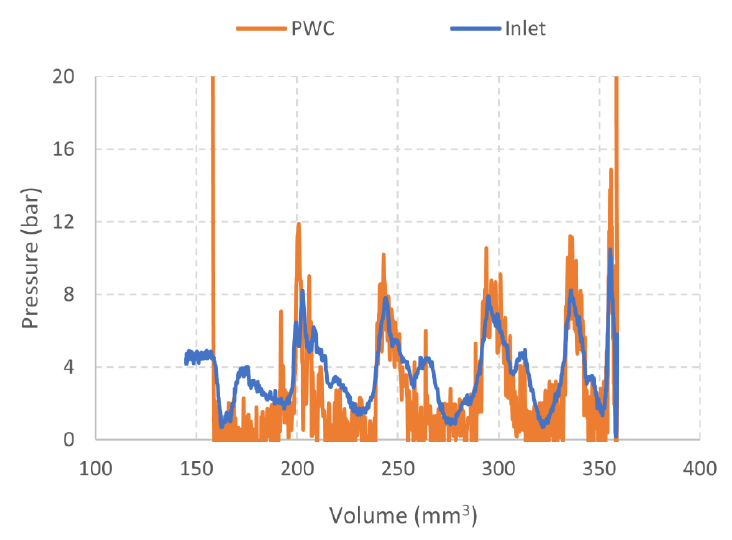
Figure 8. Suction phase on pump indicator diagram–Low-pressure, 1500 RPM, D100.